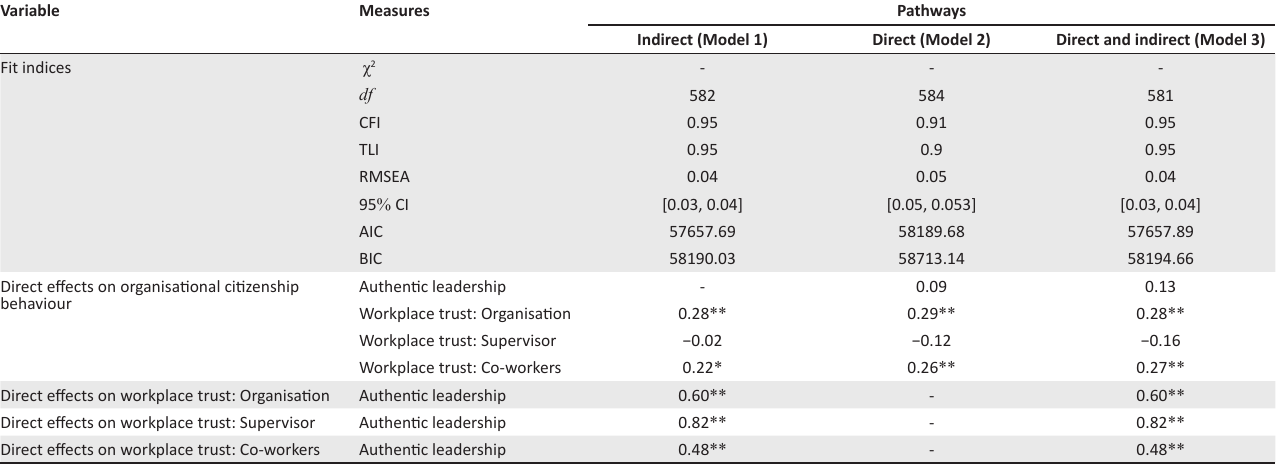
TABLE 6: Initial framework fit indices and standardised path coefficients. Variable